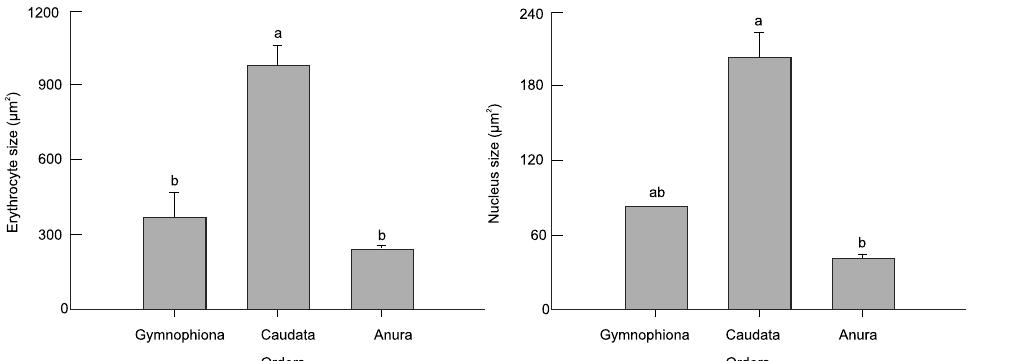
figure.Figure 4 The erythrocyte size and nucleus size of different orders in Amphibia. Different superscripts indicate significant difference (Tukey’s post hoc test, (cid:2) = 0.05, a >